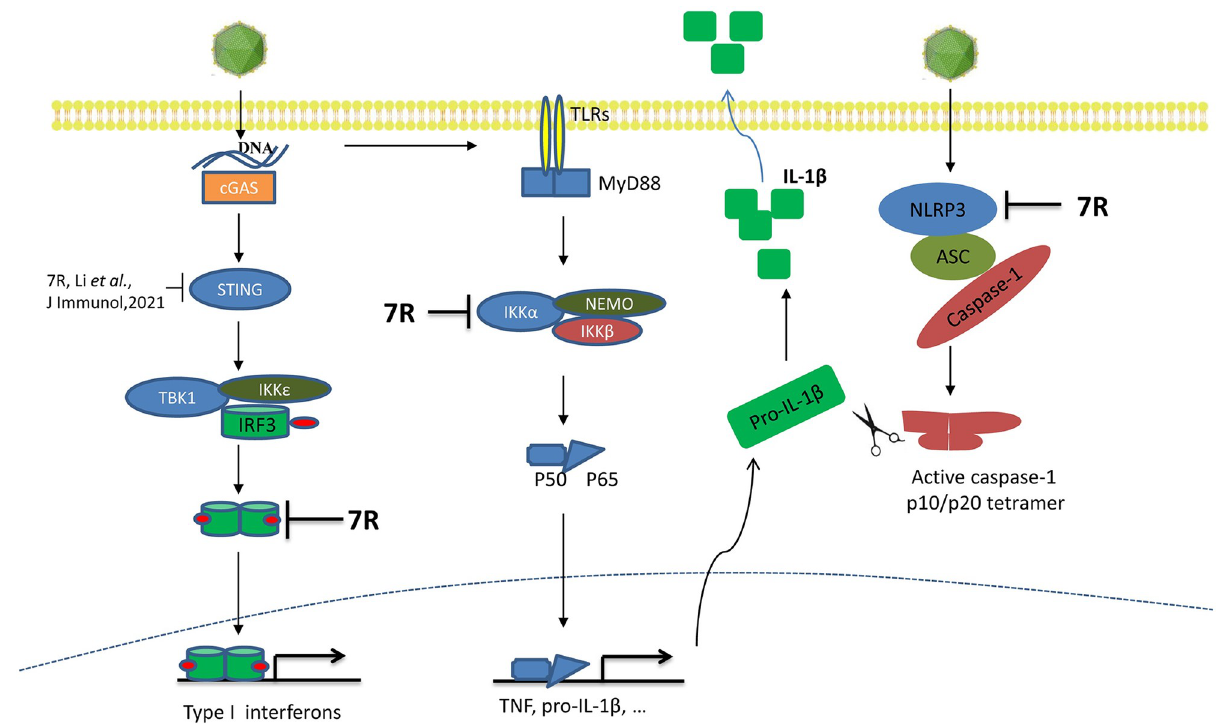
Fig 11. Schematic model of pMGF505-7R inhibits IL-1 β and type I IFN production. After ASFV infection, pMGF505-7R inhibits IL-1 β and IFN- β production. Mechanistically, pMGF505-7R interacts with IKK complex to inhibit NF- κ B activation and binds to NLRP3 to inhibit inflammasome formation, leading to decrease IL-1 β production. Moreover, pMGF505-7R inhibits the nuclear translocation of IRF3 to block type I IFN production.